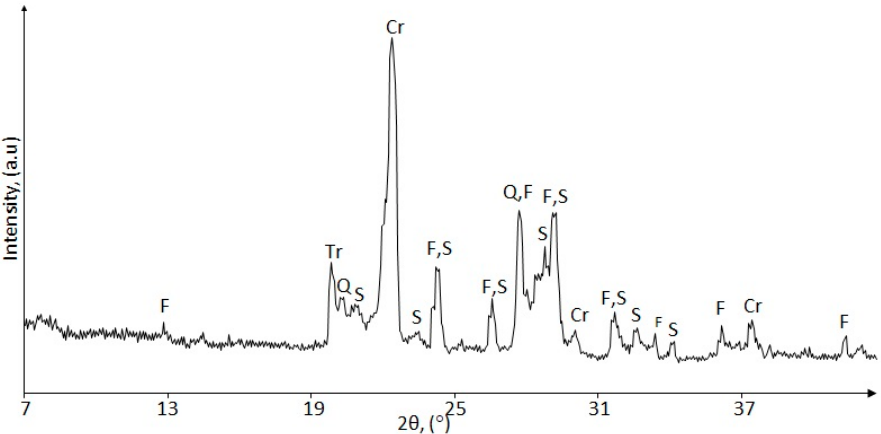
Figure 7. Sample XRD pattern containing high quantities of cristobalite (Cr—Cristobalite; Tr—tridymite; Q—quartz; S—sanidine; F—Plagioclase Feldspar).